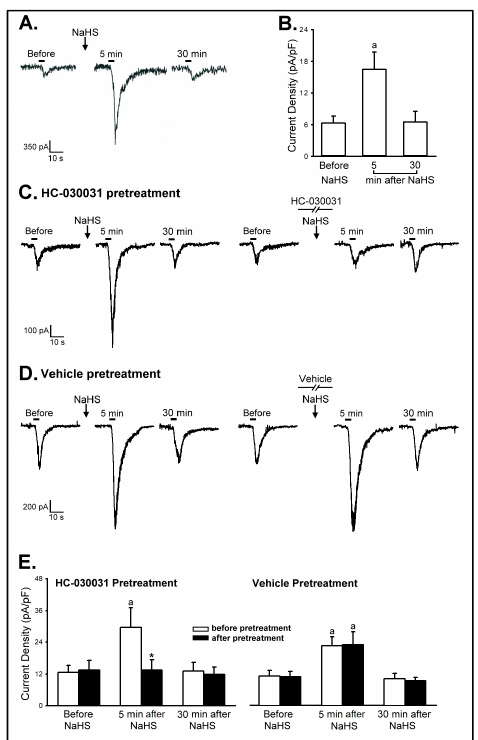
Figure 7. The role of TRPA1 receptors in sodium hydrosulfide (NaHS)-induced potentiating e ff